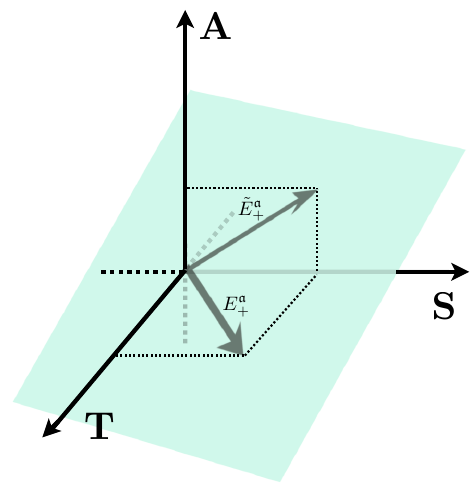
Figure 2 . Choice of +1 eigenvectors. For O ( N ) , where r + = 2 and r − = 1 , the r + eigenvectors (green) of the crossing matrix with eigenvalue +1 can be chosen with all non-negative components. We can choose 1 = r + − r − eigenvector with parity odd components set to zero and the other r − eigenvector(s) ˜ E a to have zero non-singlet parity even +